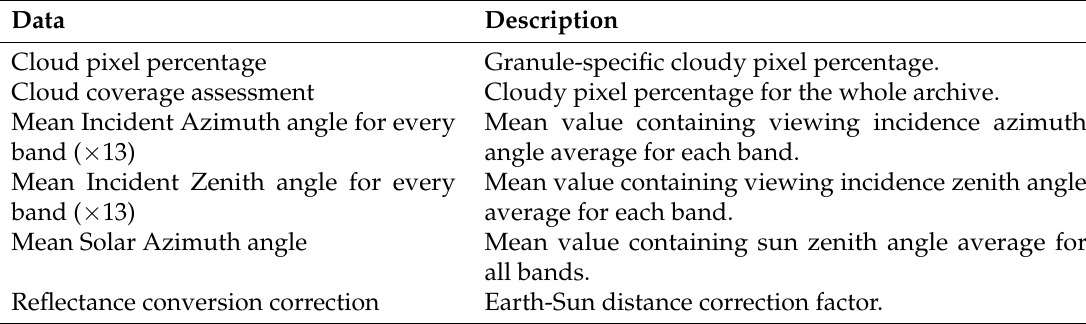
Table 5. Other information used in this study from Sentinel-2, obtained from